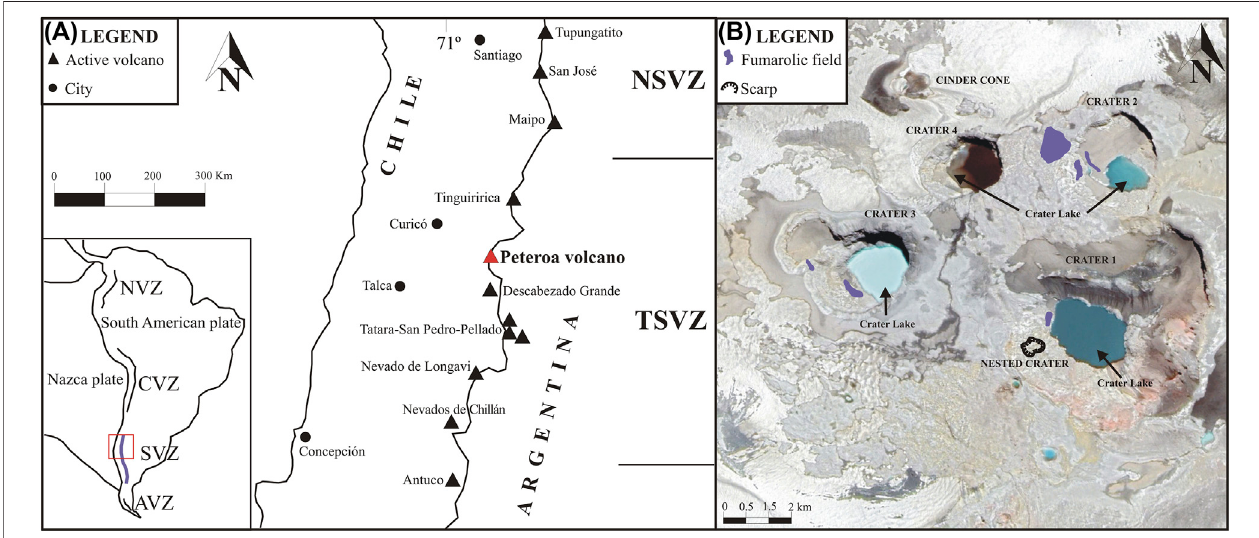
FIGURE1|(A) Location map ofPeteroa volcano.NSVZ: NorthernSouthern VolcanicZone oftheAndes; TSVZ: Transitional Southern VolcanicZone oftheAndes. (B) PlanetScope image (natural color) showing the location of the crater lakes and fumarolic fi elds of Peteroa volcano. The location of the new nested crater is also